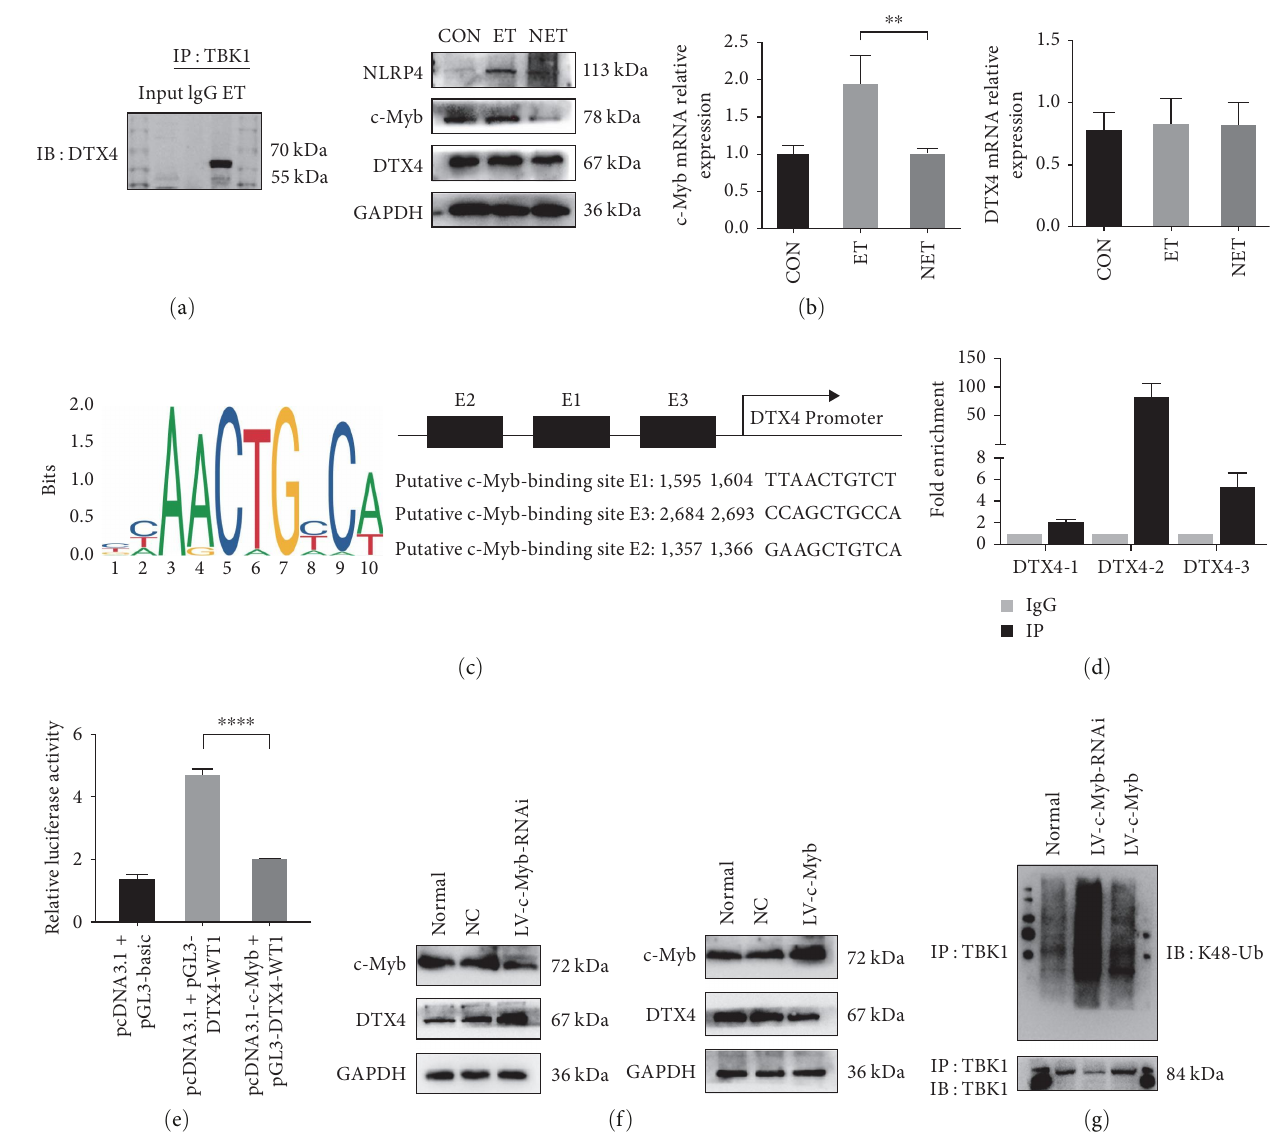
F IGURE 4: The transcription factor c-Myb can negatively regulate DTX4 to induce the K48-linked polyubiquitination pro fi le of TBK1: (a) the interaction between TBK1 and DTX4 in KCs was veri fi ed by immunoprecipitation (IP); (b) the protein expression of NLRP4, c-Myb, and DTX4 in KCs was detected by Western blotting. Densitometric analysis of the Western blotting data; (c) position weight matrix of transcription factor c-Myb binding site (right panel). The c-Myb binding sites and the fi rst three binding sequences of the DTX4 promoter regions were obtained from the JASPAR website (left panel); (d) the ChIP assay was performed in HEK293T cells to verify the three binding sequences of c-Myb in the DTX4 promoter region; (e) luciferase reporter assay was performed in HEK293T cells to verify that transcription factor c-Myb could negatively regulate DTX4; (f) the regulation of c-Myb on DTX4 in RAW264.7 cells was detected by Western blotting; (g) K48-linked polyubiquitination of TBK1 in RAW264.7 cells was detected. Data are represented as the mean Æ SD of at least three independent experiments; one-way ANOVA with Dunnett ’ s multiple comparisons was used. ∗∗ p < 0 : 01, ∗∗∗∗ p < 0 :